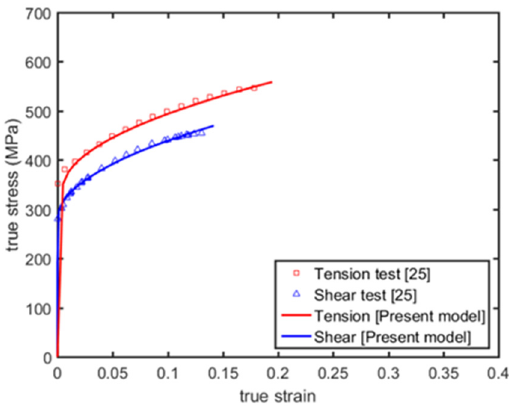
Figure 15. Comparison of the true stress-true strain curves between the present model predictions and test data for 2024-T351 aluminum alloy in tension and pure shear at room temperature.